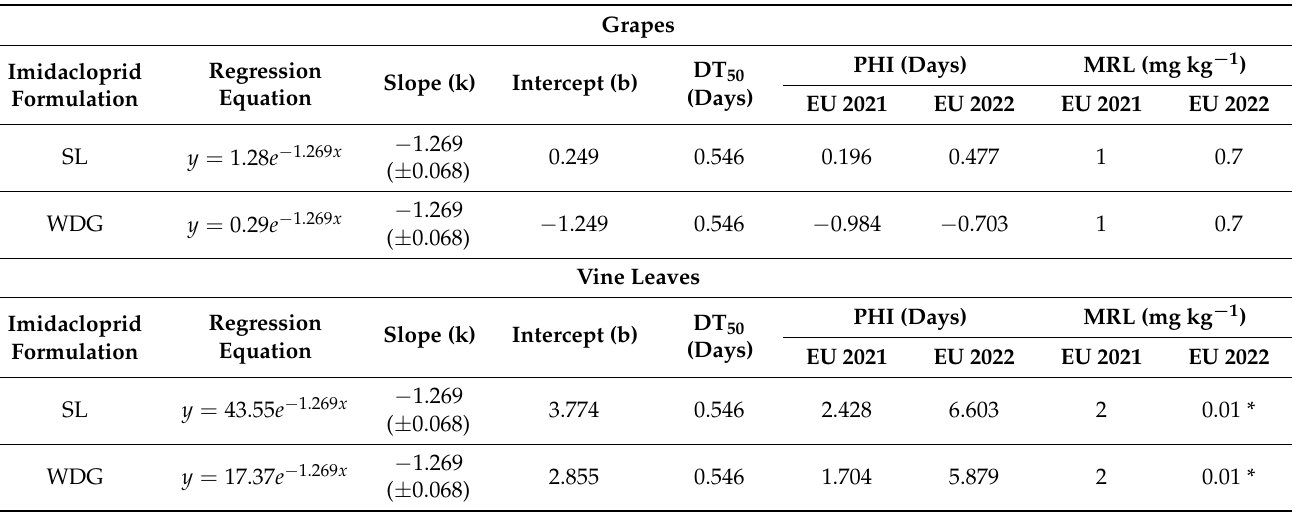
Figure 1. ( a ) Plot of residual Imidacloprid on a linear-log scale using a first order decay model. ( b ) Continuous change model of imidacloprid degradation with pooled slope but individual intercepts. Table 1. Regression equations, dissipation rates, half-life and estimated PHI according to Europe- an Union 2021 MRLs (EU 2021) and to European Union 2022 MRLs (EU 2022) for grapes and vine leaves.